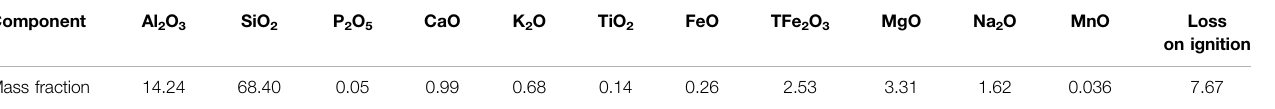
TABLE 3 | Chemical compositions of Gaomiaozi-Na-bentonite (mass fraction/%).